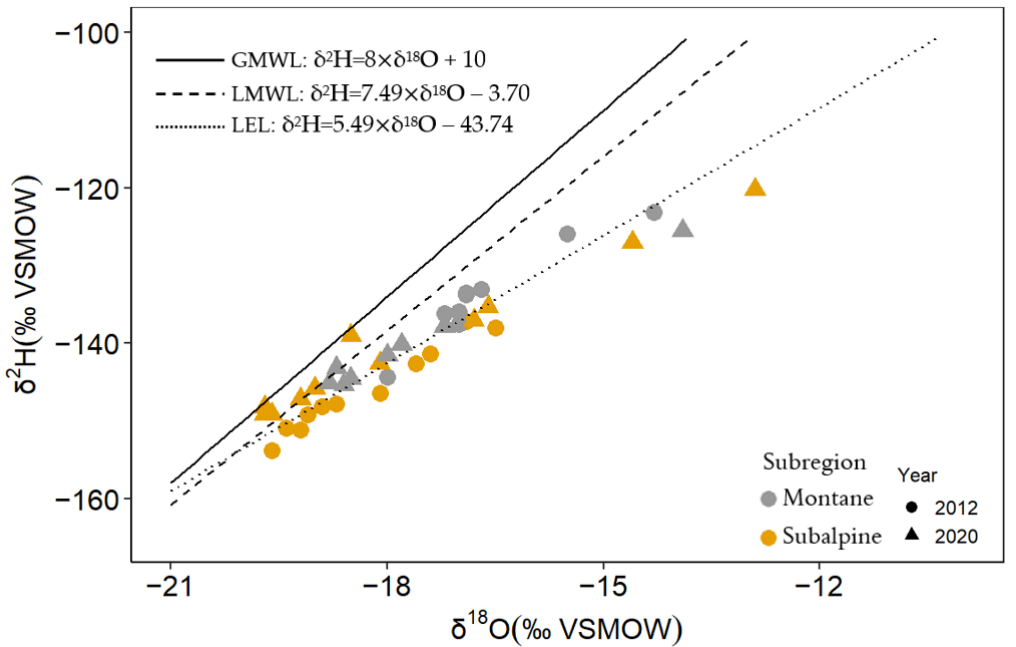
Figure 5. Dual isotope plot of surface water samples collected from beaver ponds at extensive sites during the 2012 growing season (June–July) and 2020 peak- and post-growing season (August– September). Natural Subregion of Interest is depicted by color and year is depicted by shape. LMWL and LEL taken from Katvala et al. [40] for the Kananaskis Valley,